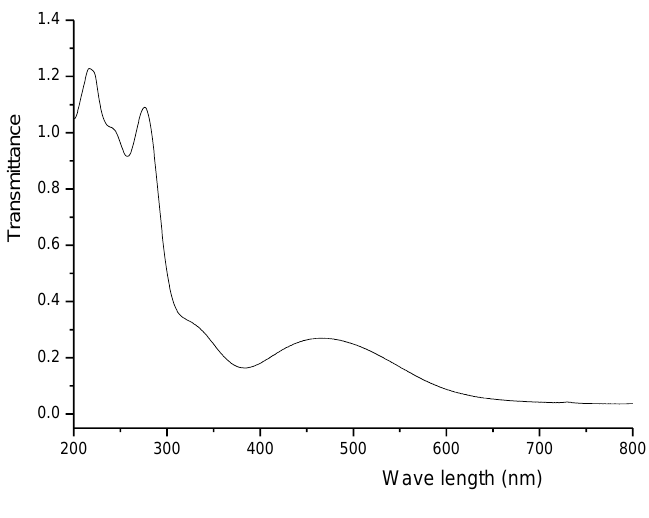
Fig. S6. UV-Vis spectrum of complex 2